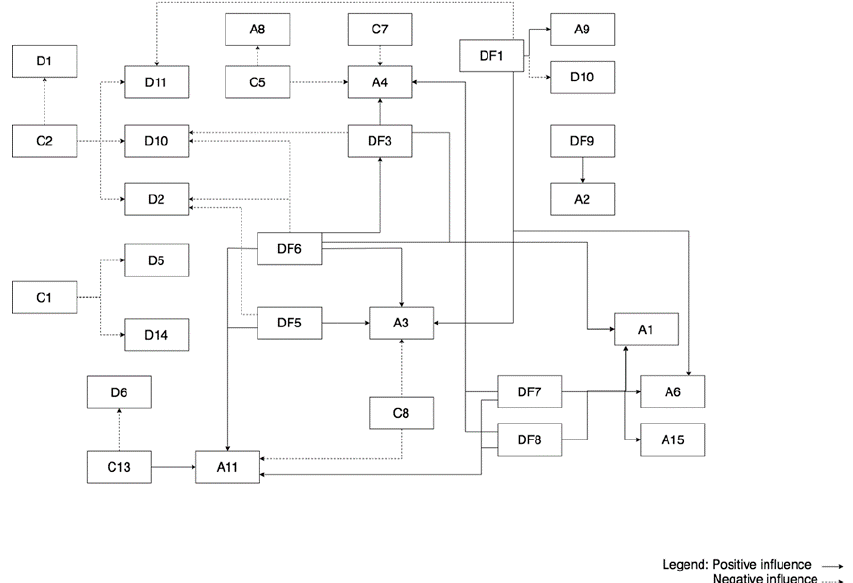
Figure 3. Model detailing how RW decision factors influence each other.